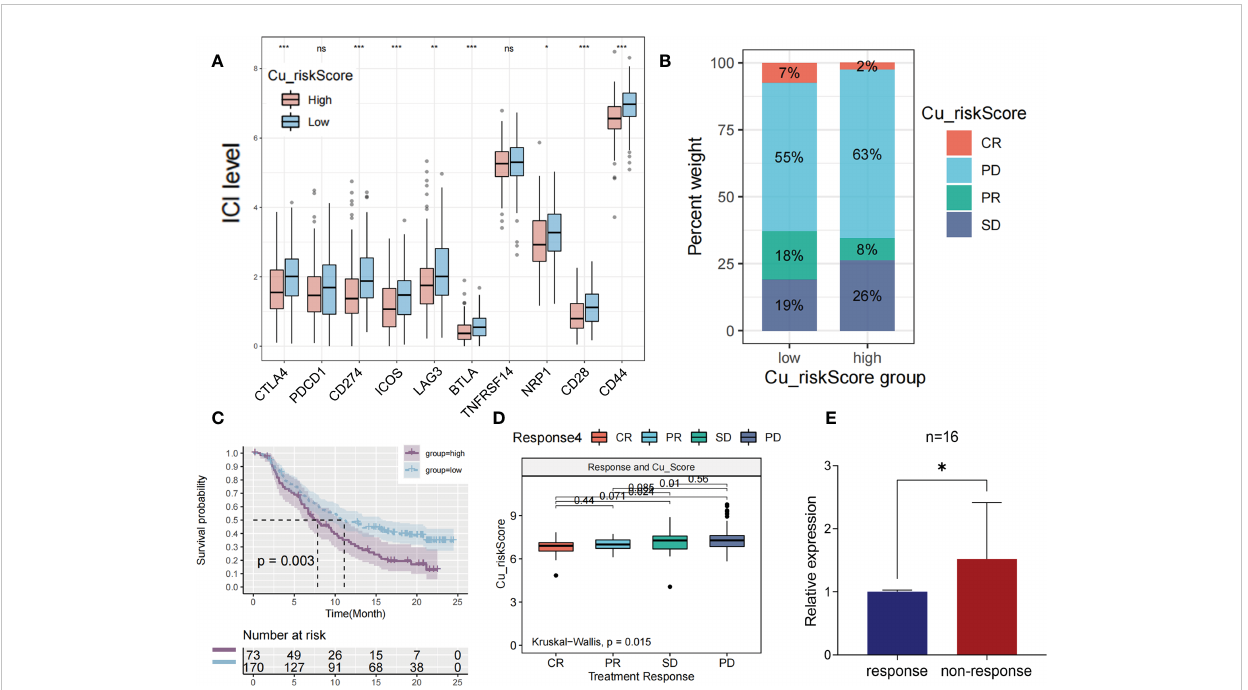
FIGURE 6 The prediction of immunotherapeutic ef fi cacy based on cuproplasia signature (A) Boxplot showing the differential expression of immune checkpoint between Cu_riskScore high and low groups. (B) Stack bar chart showing the distribution of 4 immunotherapeutic responses in two Cu_riskScore groups in TCGA. (C) Kaplan-Meier survival analysis of the patients with or without immunotherapy in Cu_riskScore high and low groups. (D) Boxplot exhibiting the different levels of Cu_riskScore among different immunotherapeutic response groups. (E) Boxplot showing the level of RNF113A in 16 pairs of patients with response or